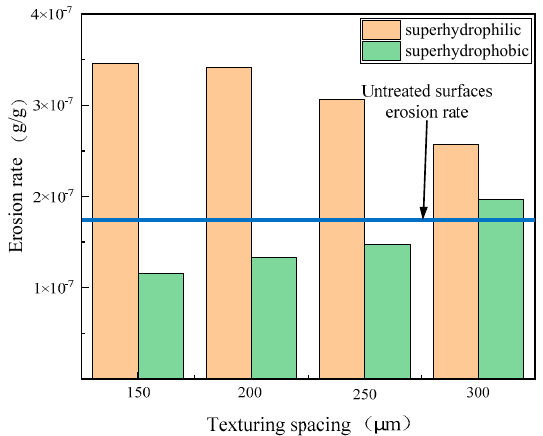
Figure 7. Comparison of erosion rates of titanium alloys with different wettability textures. (The blue line shows the erosion rate of the untreated surface.)